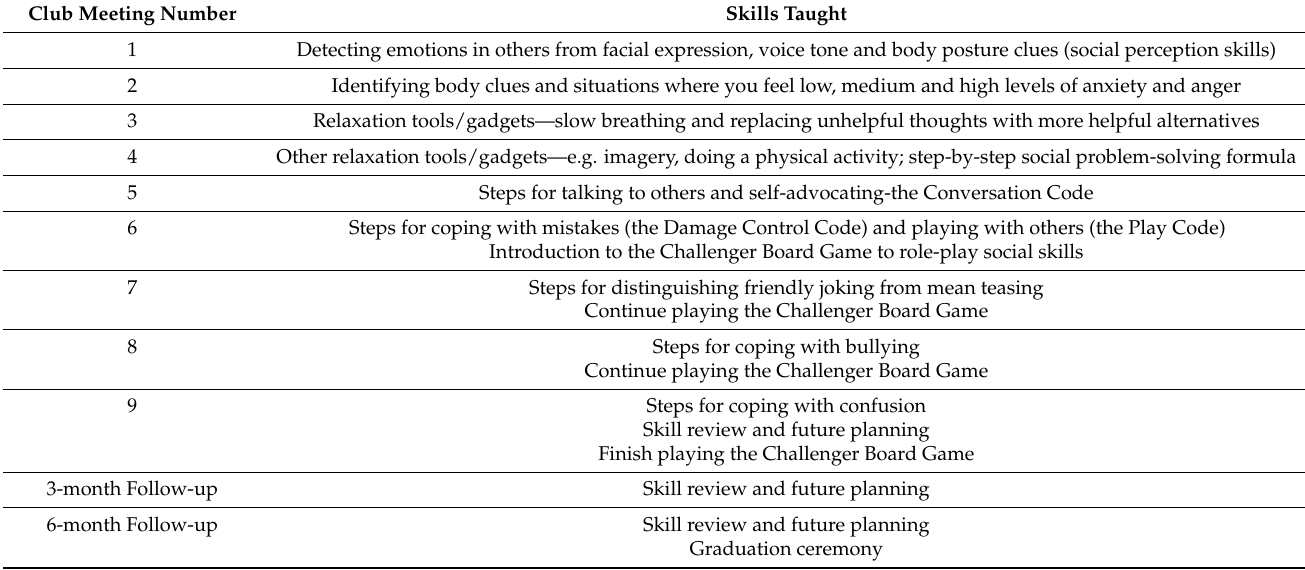
Table 2. Summary of skills taught in the Secret Agent Society small group